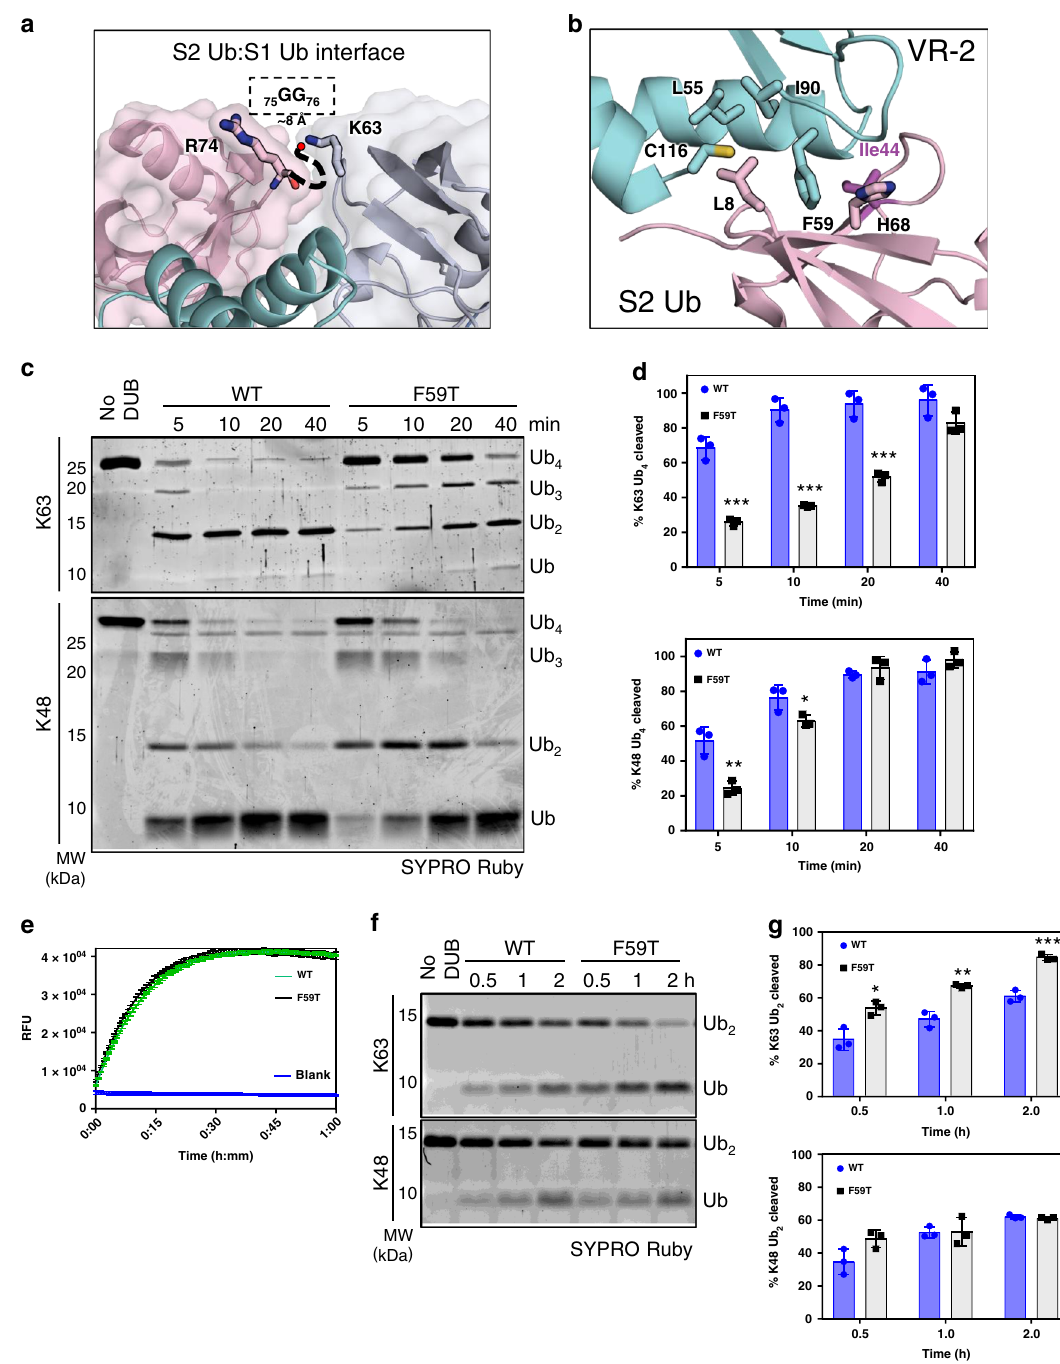
Fig. 3 The S2 ubiquitin-binding site controls preference for K63-linked chain cleavage. a Positioning of the C terminus of S2 ubiquitin (pink) and proximity to K63 of the central S1 ubiquitin (light gray) suggests a preferred orientation for K63 chains. Terminal glycines are missing from the density due to inherent fl exibility. b Detailed view of interactions at the S2 site. OtDUB VR-2 is in cyan, and S2 ubiquitin is in pink. c In vitro cleavage assays of K63 and K48 tetra-ubiquitin (Ub 4 ) chains (2 µ M) by WT and F59T OtDUB 1 – 259 (50 nM). Source data are provided as a Source Data fi le. d Quanti fi cation of Ub 4 cleavage rates using data, exempli fi ed by c , from three independent experiments. Mean values and SD (error bars) are shown. Source data are provided as a Source Data fi le. e Comparison of Ub-AMC cleavage by WT and F59T OtDUB 1 – 259 . Ub-AMC (400 nM) was incubated alone (Blank) or with 350 pM of the indicated OtDUB. Lines are the average of technical triplicates with SD bars at each 40-s interval. f K63 and K48 di-ubiquitin cleavage by WT and F59T OtDUB 1 – 259 . Di-ubiquitin (1 µ M) was incubated in the presence or absence of the indicated OtDUB (0.5 µ M) for 0.5, 1, and 2 h. Source data are provided as a Source Data fi le. g Quantitative comparison of di-ubiquitin cleavage rates using data, exempli fi ed by f , from three experiments; mean and SD values are shown. Source data are provided as a Source Data fi le. Unpaired, two-tailed t tests were performed ( d , g ) for comparisons between OtDUB 1 – 259 WT and F59T for each condition and time point (* p < 0.05, ** p < 0.005, *** p <